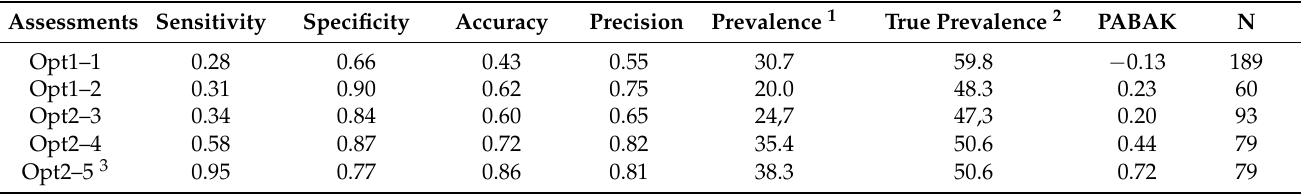
Table 3. Sensitivity, specificity, accuracy and precision of the automatic keel bone damage detection system installed at the slaughter